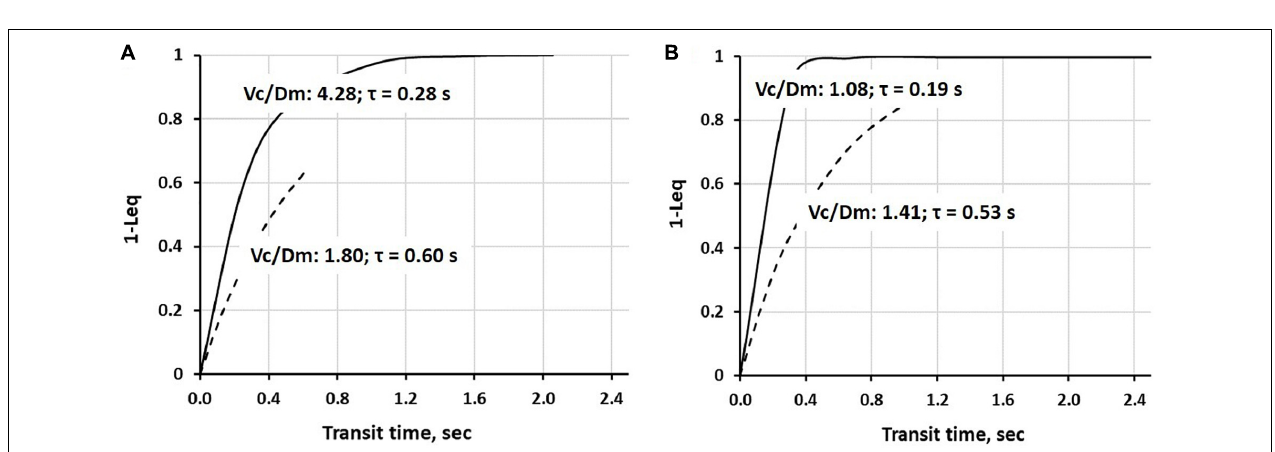
FIGURE 5 | Time course of 1- Leq (an index of alveolar-capillary equilibration) in normoxia at rest (a continuous line) and on exposure to severe hypoxia (3,840 m, P I O 2 90 mmHg, a dashed line) in two representative subjects having a high (A) or a low (B) Vc/Dm ratio at the sea level (SL) in resting condition (data from Beretta et al., 2019).